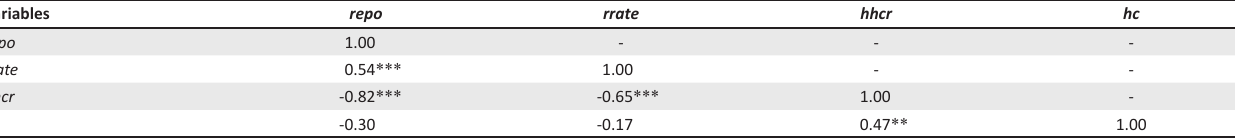
TABLE 6-A1: Correlation matrix (2007Q1–2012Q4). Variables